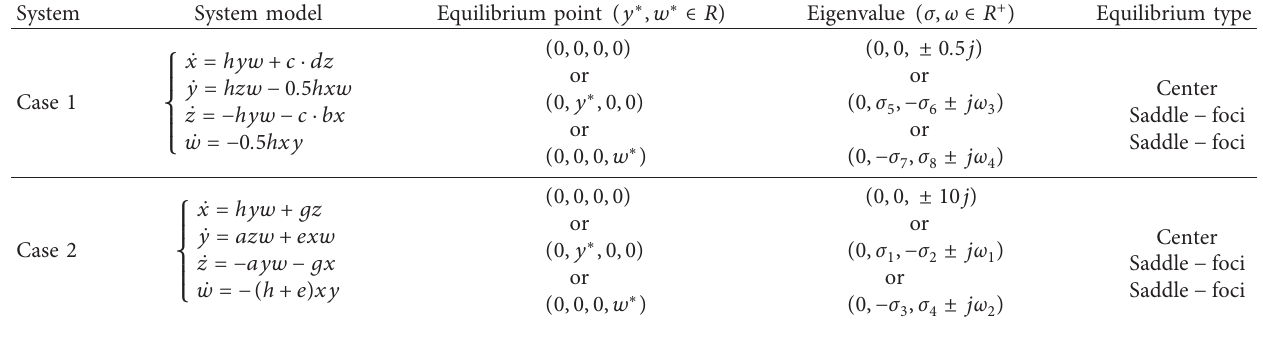
Table 1: Equilibrium point type of Case 1 and Case 2 systems.